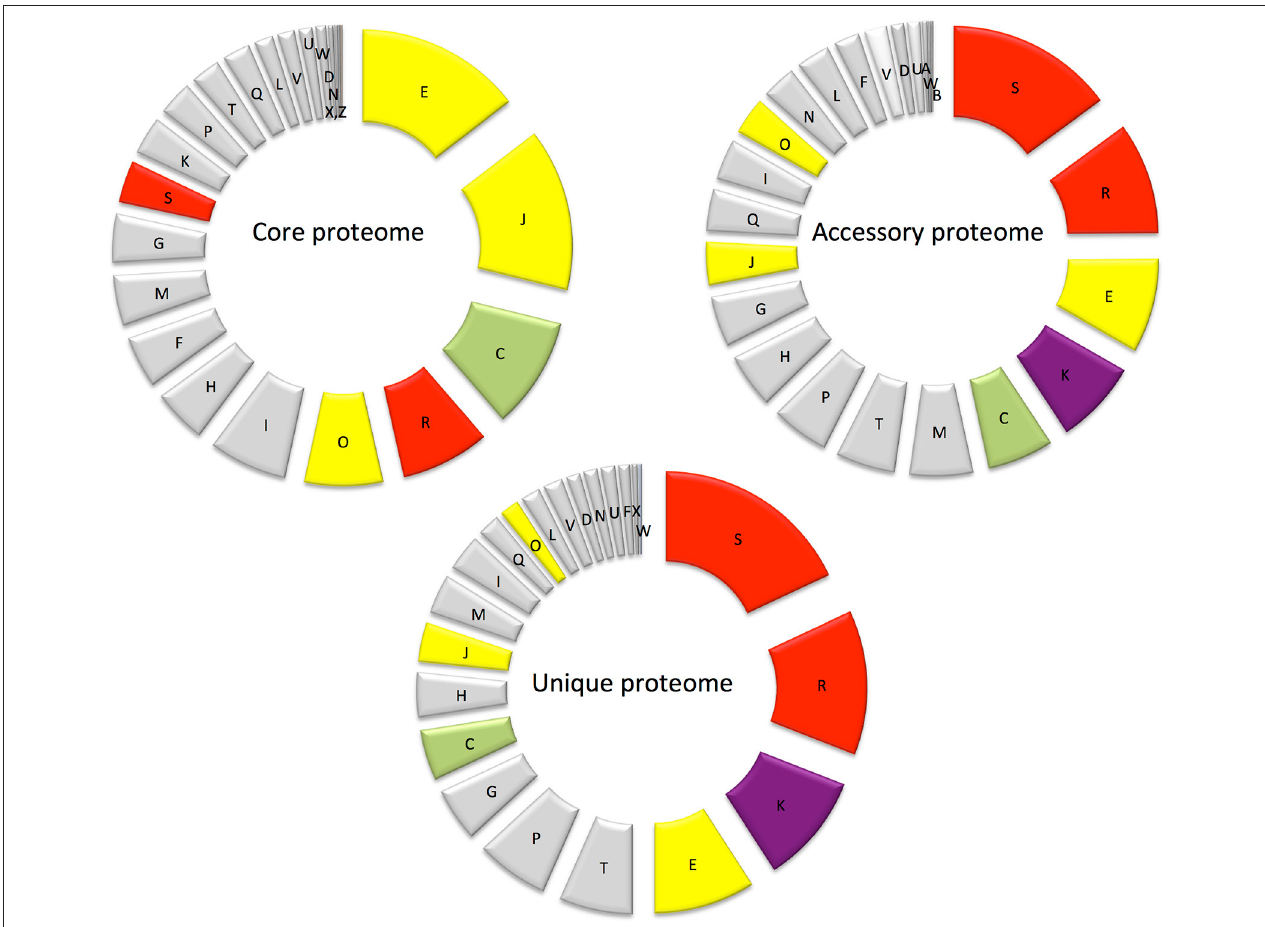
FIGURE 5 | Diagram showing the abundance of proteins in each COG in the core proteome, randomly expressed and unique